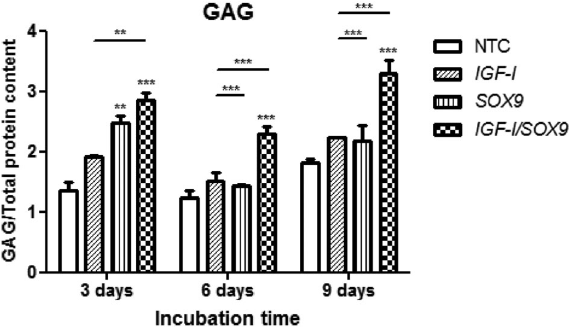
Figure 5. Glycosaminoglycans (GAG) produced by the chondro- cytes. The conditioned media from each culture condition were mixed with dimethyl methylene blue dye, and the amount of GAG was quanti fi ed by spectrophotometry. The bars correspond to the non-transfected chondrocytes (NTC) and those transfected with pCMV-SPORT6 IGF-I ( IGF-I ), pCMV-SPORT6 SOX9 ( SOX9 ), or both plasmids ( IGF-I/SOX9 ). Data are reported as the mean and standard deviation of the data normalized to the total protein content based on three experiments on days 3, 6, and 9 post- transfection. ***P o 0.001 and **P o 0.01 vs NTC; other signi fi cant differences are indicated with lines (two-way ANOVA with Bonferroni post hoc